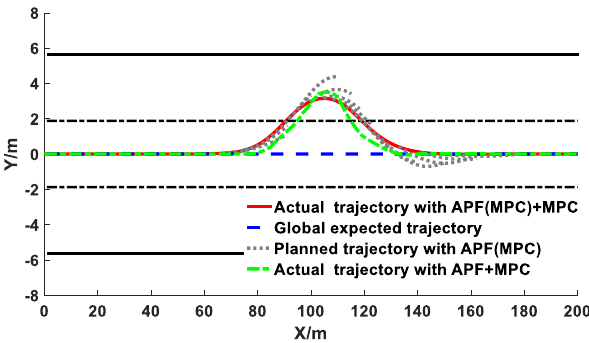
Figure 15. Co-simulation results of obstacle avoidance trajectory planning under 40 km/h.